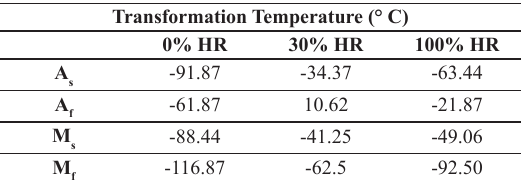
Table 1 - Cu-Al-Be-Cr alloy phase transformation temperatures. Transformation Temperature (°